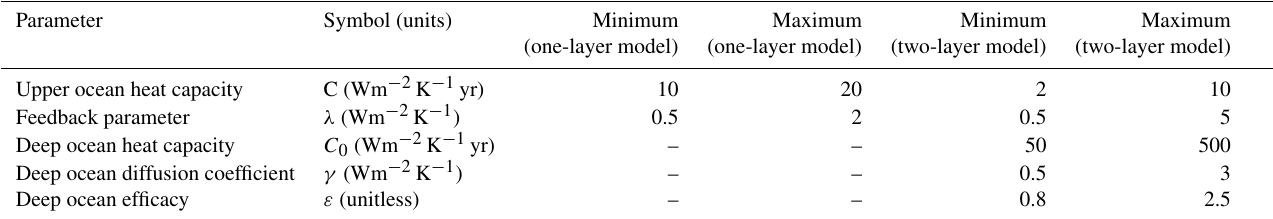
Table 1. Parameters used in the one- and two-layer models in the idealised example, and the upper and lower bounds of the sampling range used in the ensemble